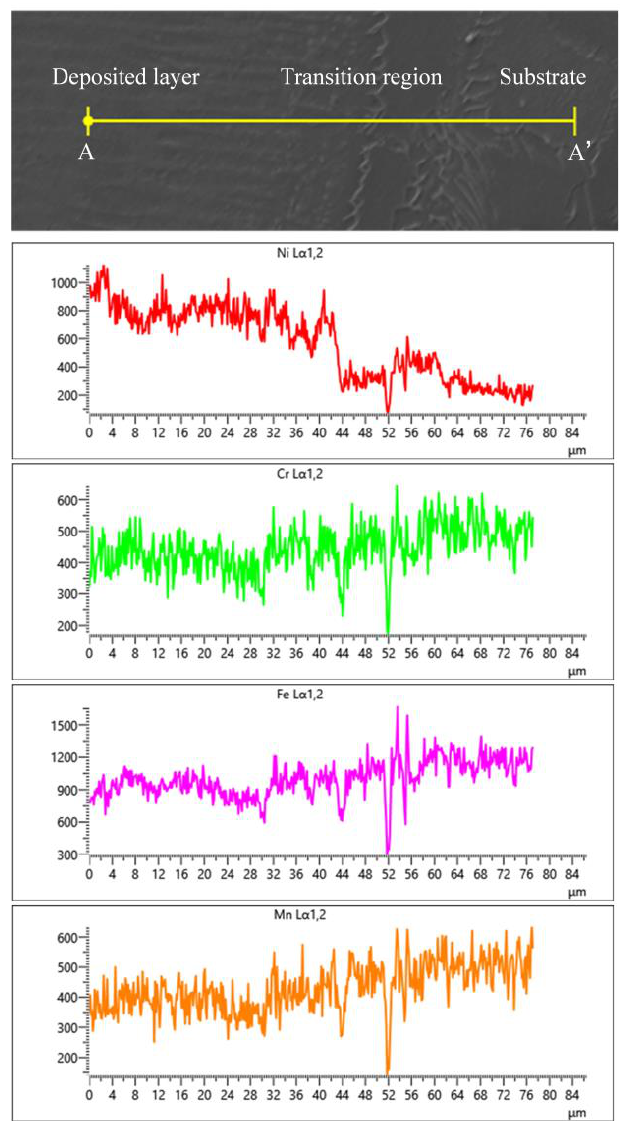
Figure 4. Element distribution from the laser-UHF induction hybrid deposited layer to the substrate.